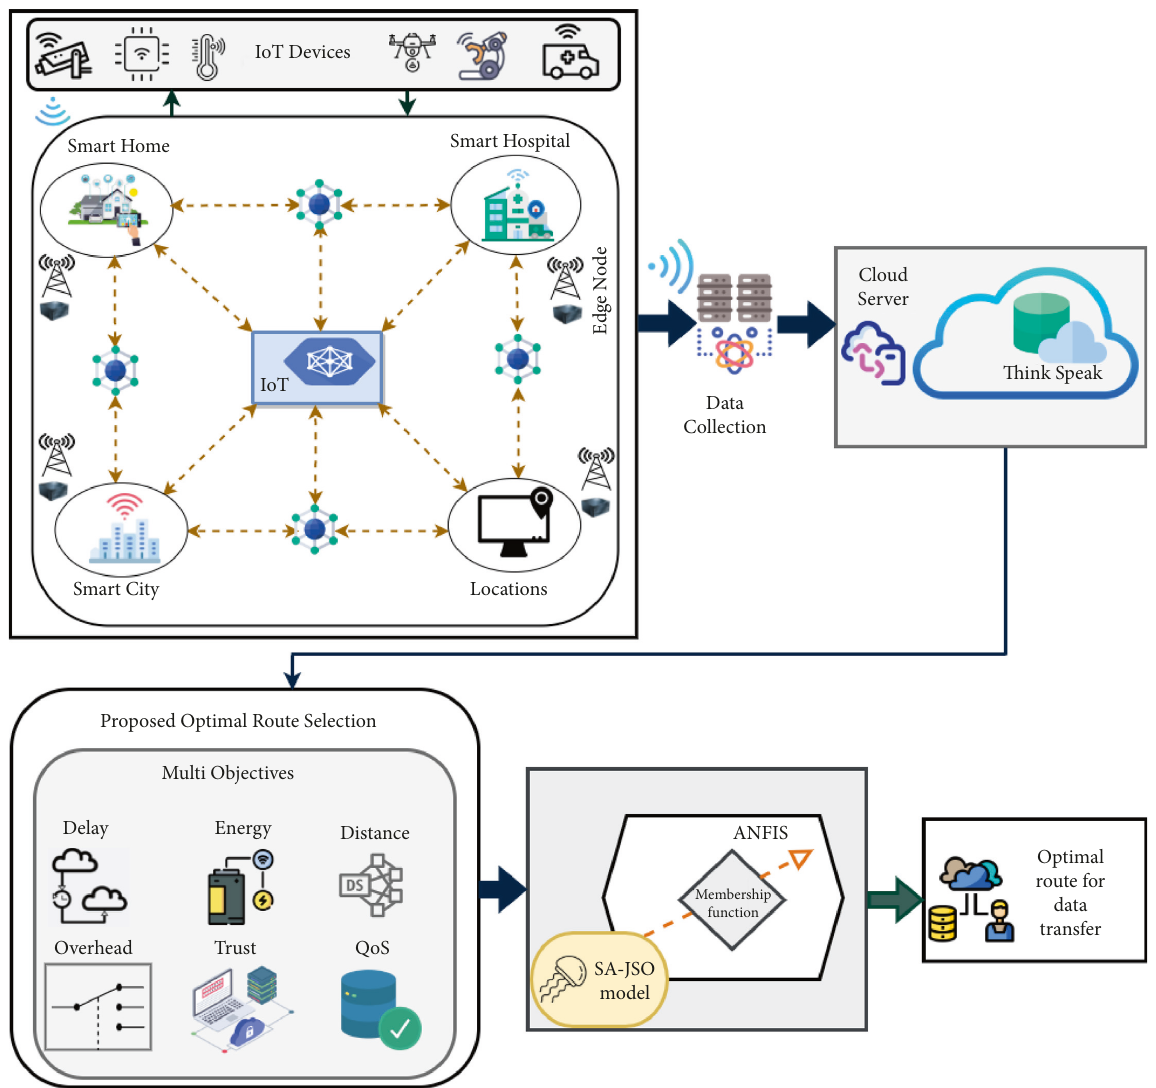
Figure 1: Architecture of the proposed routing